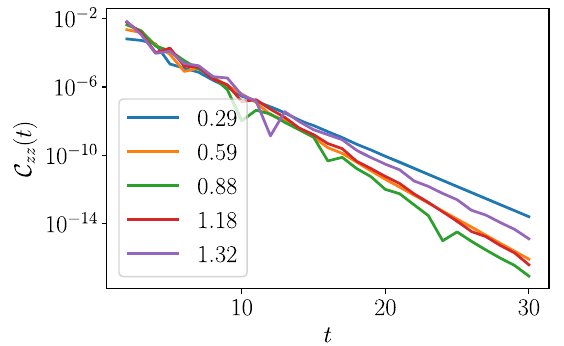
FIG. 9. Decay of the polarization autocorrelation C zz ð t Þ defined in Eq. (32) versus time close to the PD point ( δ J ¼ δϵ ¼ 0 . 06 ) for different values of h . The drop is exponential with a decay rate that depends on h